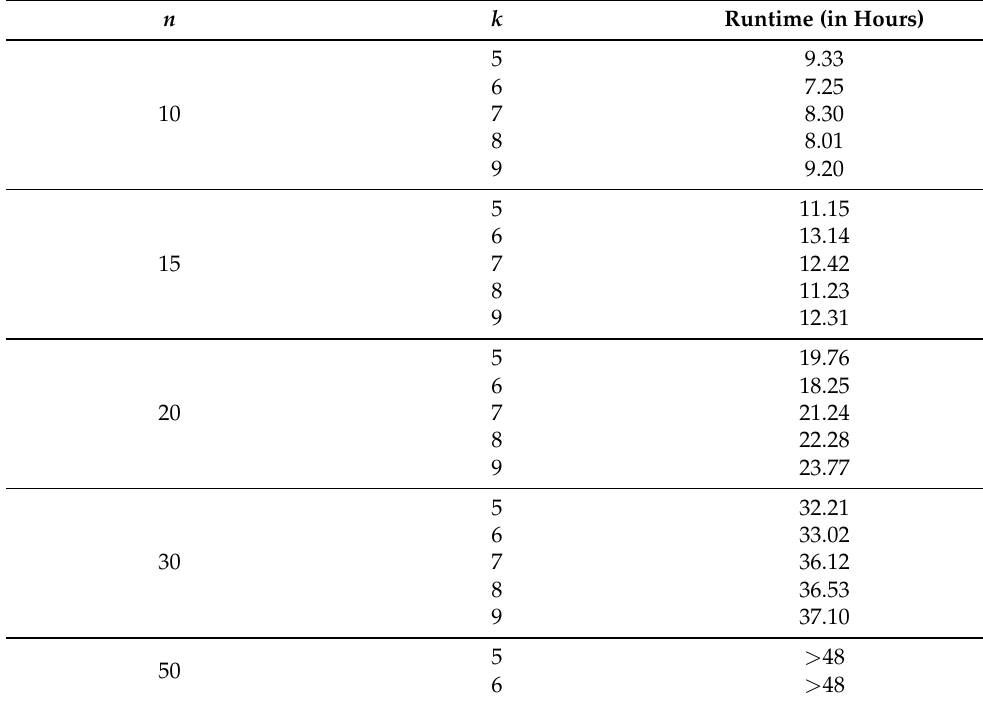
Table 6. Computational study results for the indicated n and k